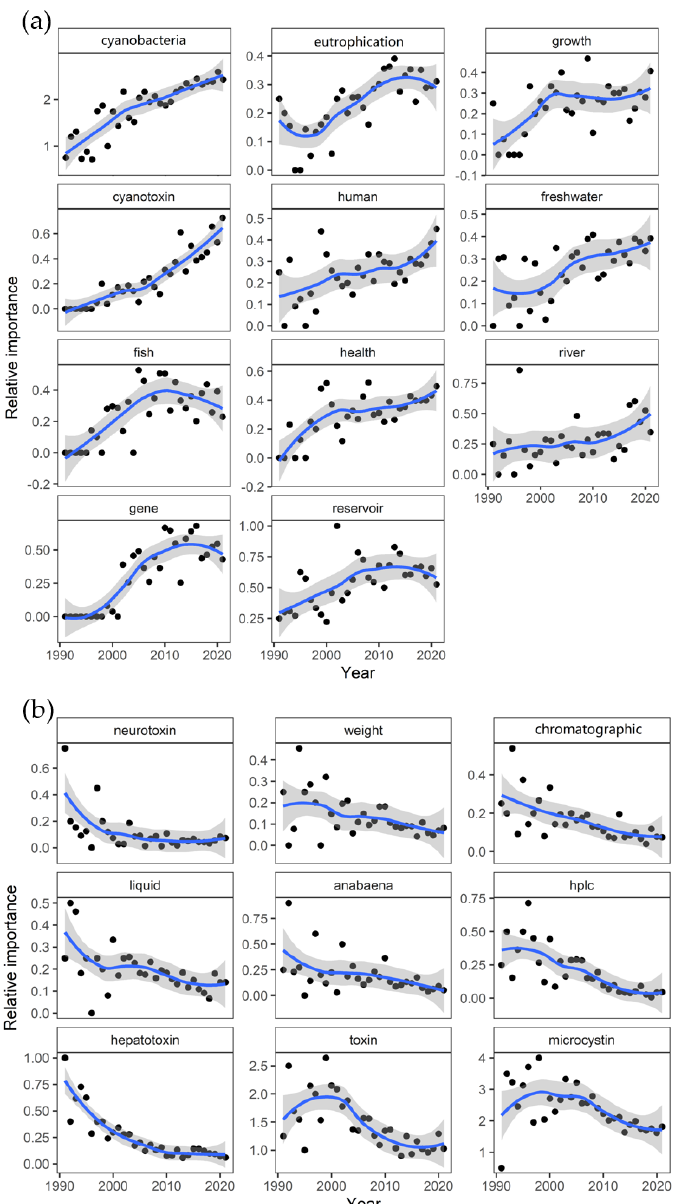
Figure 3. The interannual changes in the relative rankings of the 20 words with practical meaning. ( a ) The upward trend of the relative importance of words. ( b ) The downward trend of the relative importance of words.